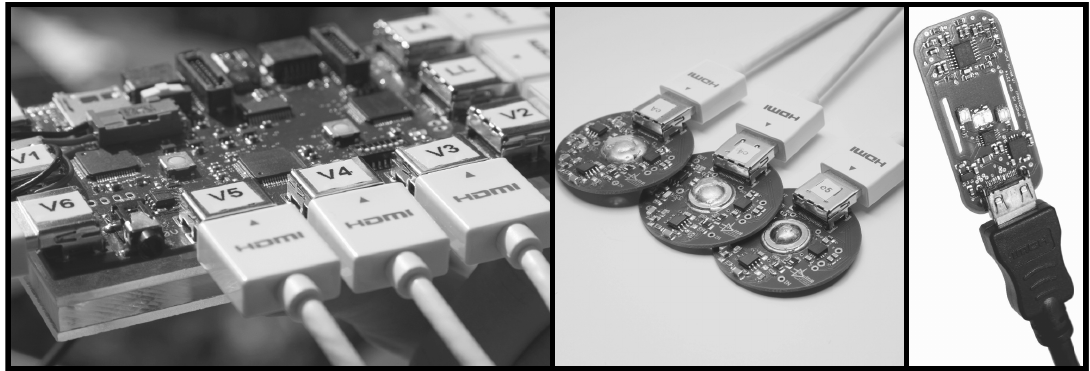
Figure 2. Assembled hardware system: ( a ) ECG sensor mainboard; ( b ) active ECG electrodes; and the ( c ) PPG module for acquiring the optical pulse wave